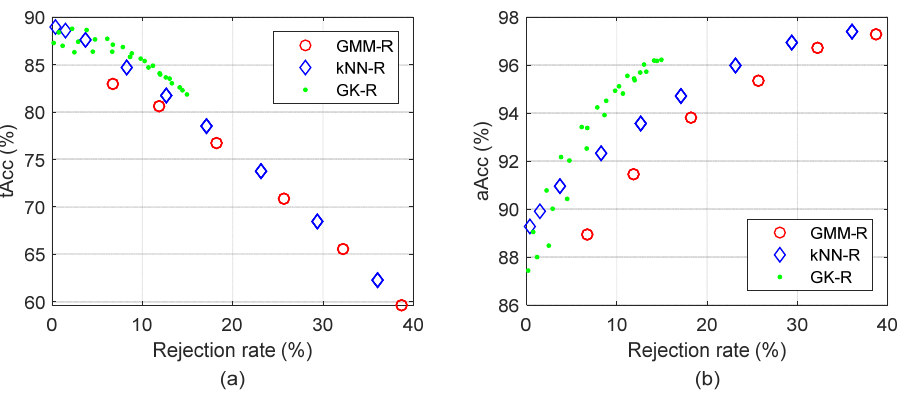
Figure 4. Comparison of movement recognition with GMM-R, kNN-R and GK-R with varying parameters. ( a ) Average tAcc versus rejection rate. ( b ) Average aAcc versus rejection rate.